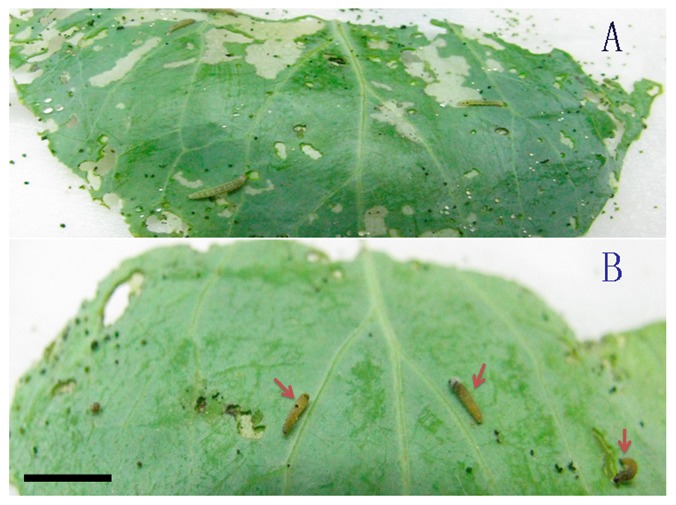
Laboratory bioassay of Si-ace2_001 against the larvae of Plutella xylostella.
A is a negative control treated by DEPC water. B showed the samples treated with Si-ace2_001 and red arrowheads indicated the dead insects. Scale represents 1 cm.